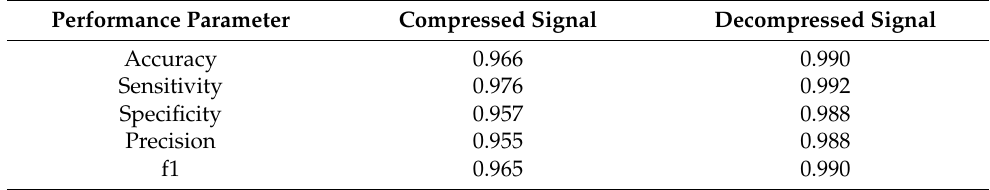
Table 4. Classification performance of the compressed signal and the decompressed signal database.